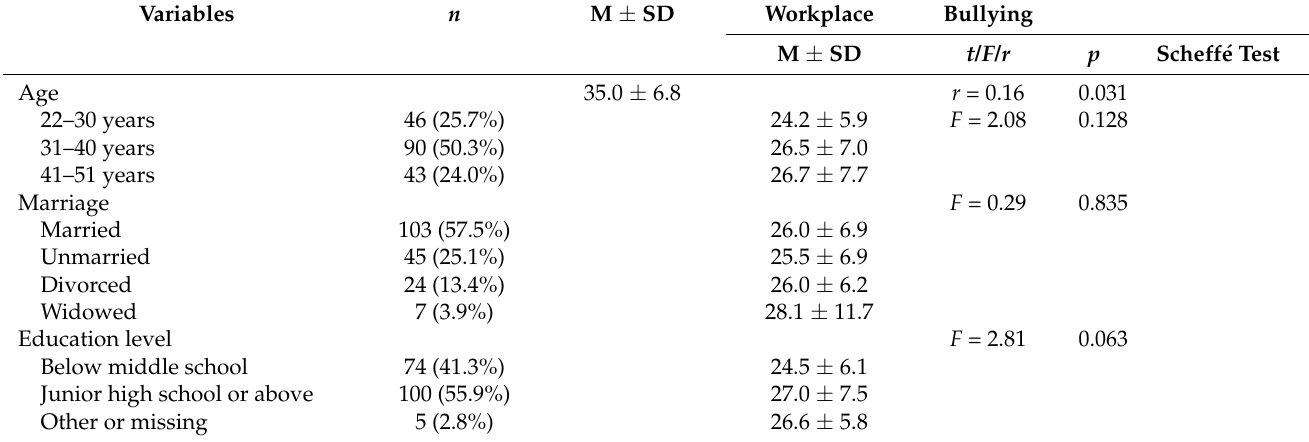
Table 1. Distribution and analysis of personal characteristics, sleep quality, and mental health with workplace bullying among Indonesian caregivers ( N =